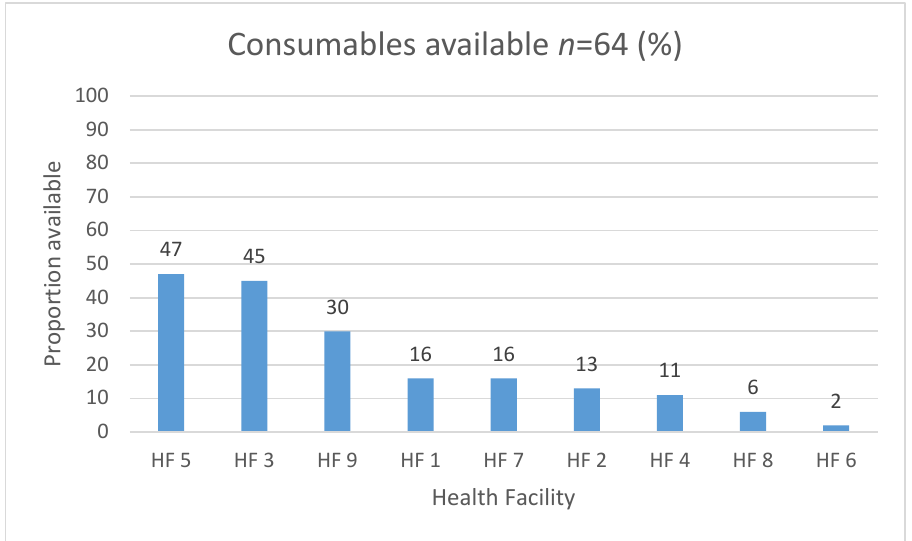
Figure 4. Availability of consumables by proportion in health facilities.